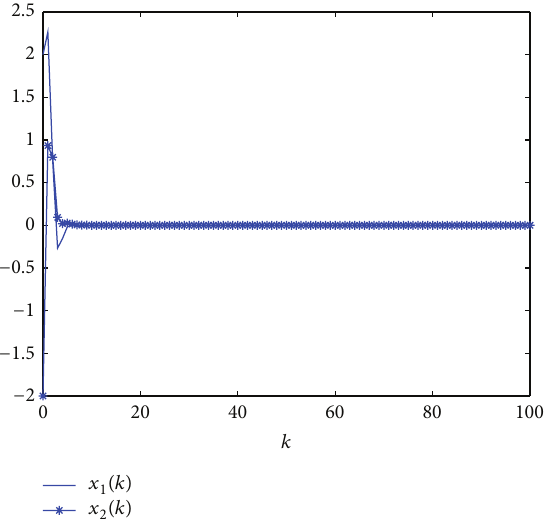
Figure 2: State evolution 𝑥(𝑘) of controlled